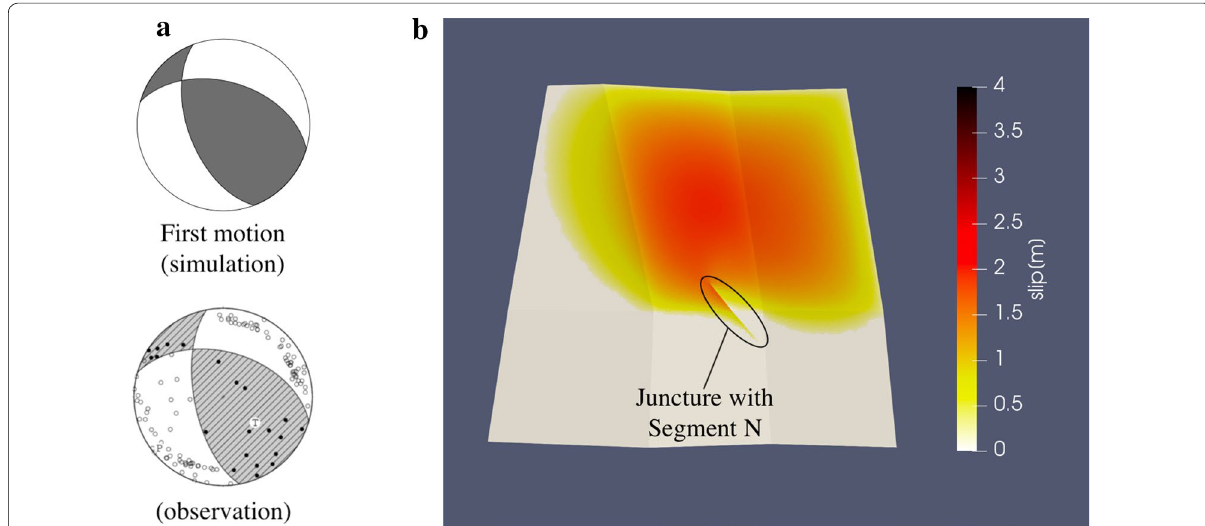
Fig. 9 Simulated slip in Case B. a The simulated and observed first motion focal mechanisms. b The final slip distribution